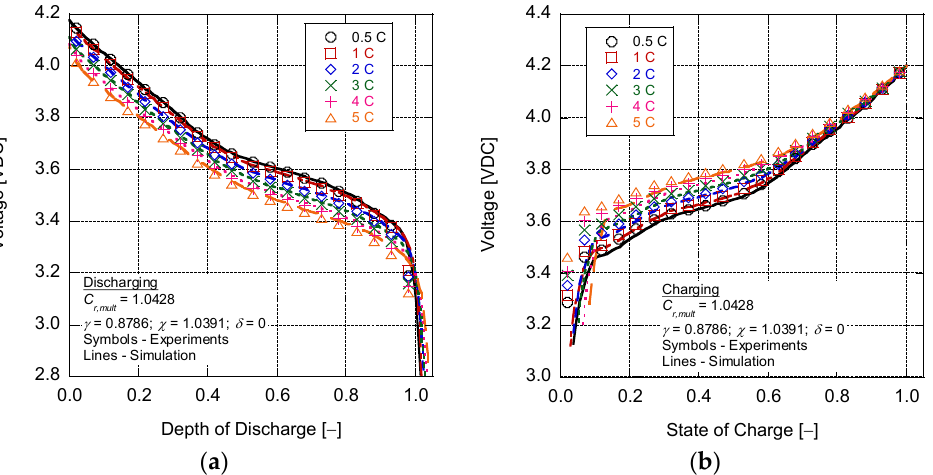
Figure 4 . Experimental data and model results of a representative NCM 622 battery during ( a ) discharging and ( b ) charging events.